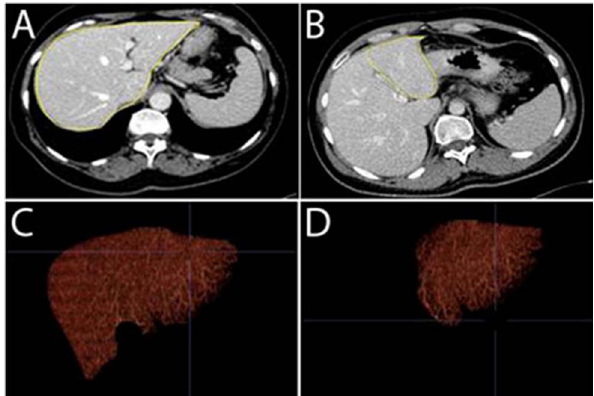
Figure 4. Manual Commercial Software (TR) – Image Example. A Transverse image of the portal-venous phase – manual outline of the entire liver (yellow). B Transverse image of the portal-venous phase – manual outline of liver segments II/III (yellow). C Volume rendering (coronal view) resulting after manual outline of the entire liver. D Volume rendering (coronal view) resulting after manual outline of liver segments II/III. Note: in each live liver donor, CT-volumetry of the entire liver as well as of the future liver graft (transplanted liver segments) were performed to ensure that the postoperative liver volume is adequate.